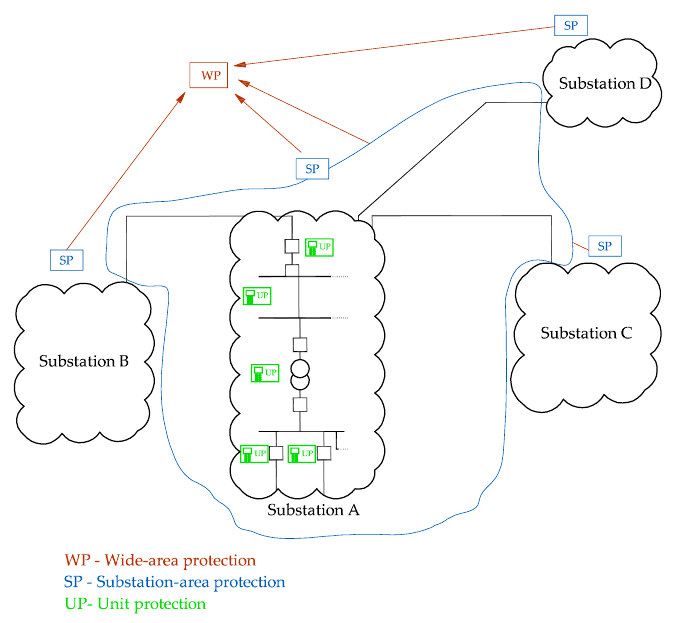
Figure 6. Protection system architecture for Smart Grid.